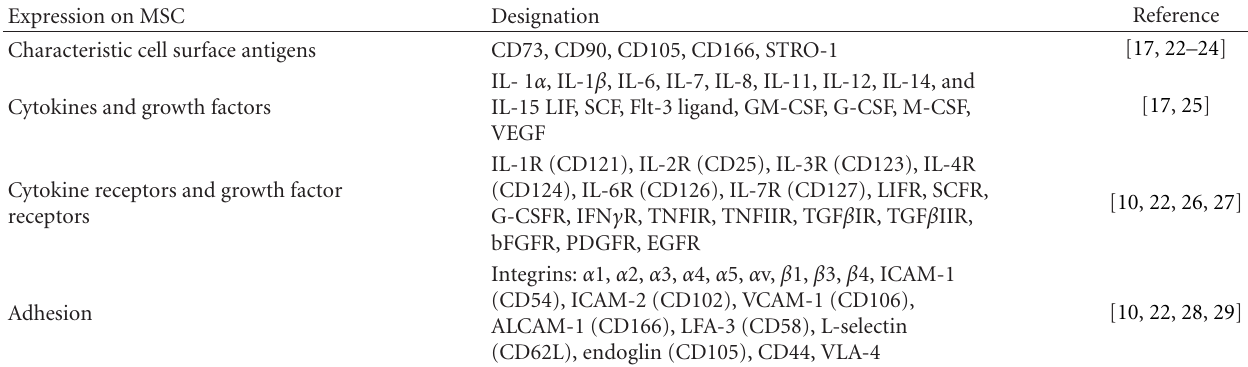
Table 1: Characteristics of bone marrow-derived MSC: expression of specific antigens, cytokine receptors and adhesion molecules, as well as production of cytokines and matrix